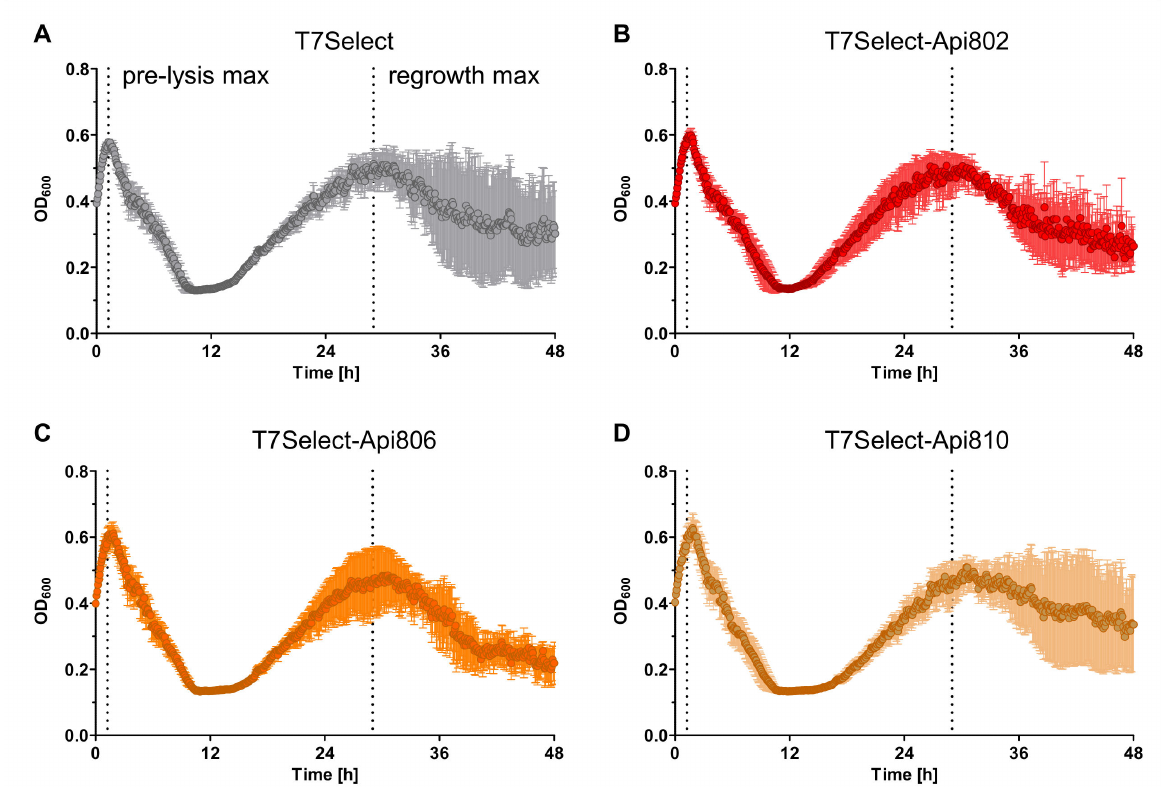
Figure 5. Bacterial growth of E. coli Rosetta cultures infected with engineered T7Select phages (MOI 0.0625) without ( A ) (gray) or with Api802 ( B ) (red), Api806 ( C ) (orange), or Api810 ( D ) (beige) inserts. Shown are the OD 600 values recorded every 5 min for 48 h. Dashed lines indicate the highest optical density before lysis (pre-lysis max) and the highest optical density of regrowth phase (regrowth max). Experiments were completed twice in quintuplicates. Error bars show the standard deviation of all five replicates of one representative